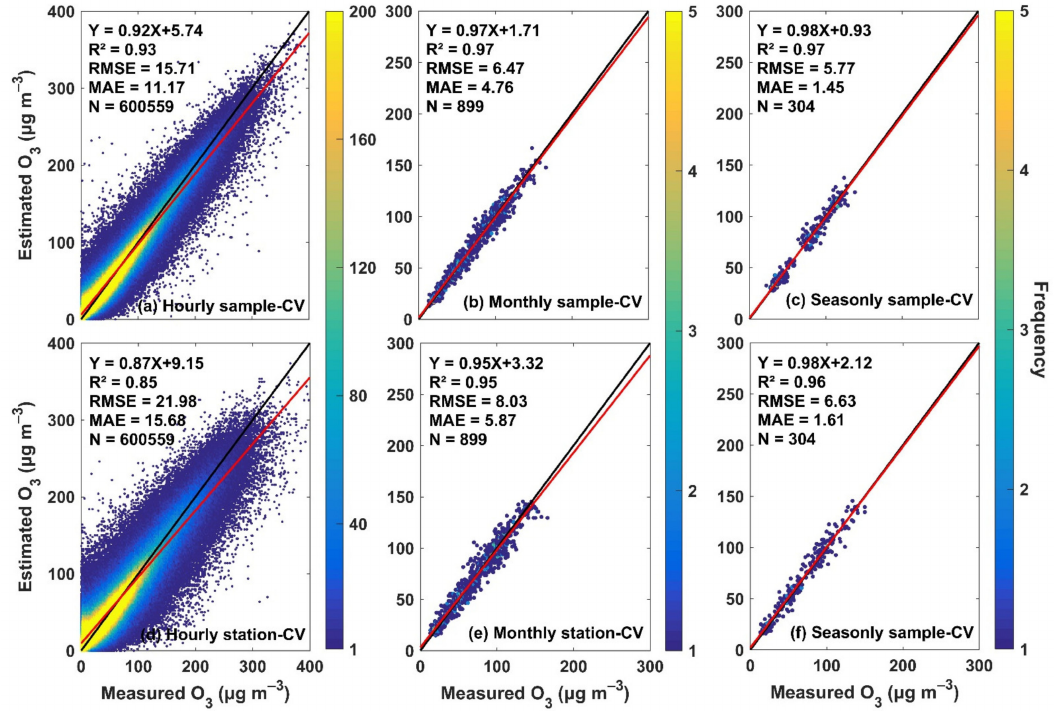
Figure 5. Sample-based and station-based 10-fold CV of the O 3 concentration estimated on hourly ( a , d ), monthly ( b , e ), and seasonal ( c , f ) time scales in the BTH region in 2018. The color bar indicates the number of data